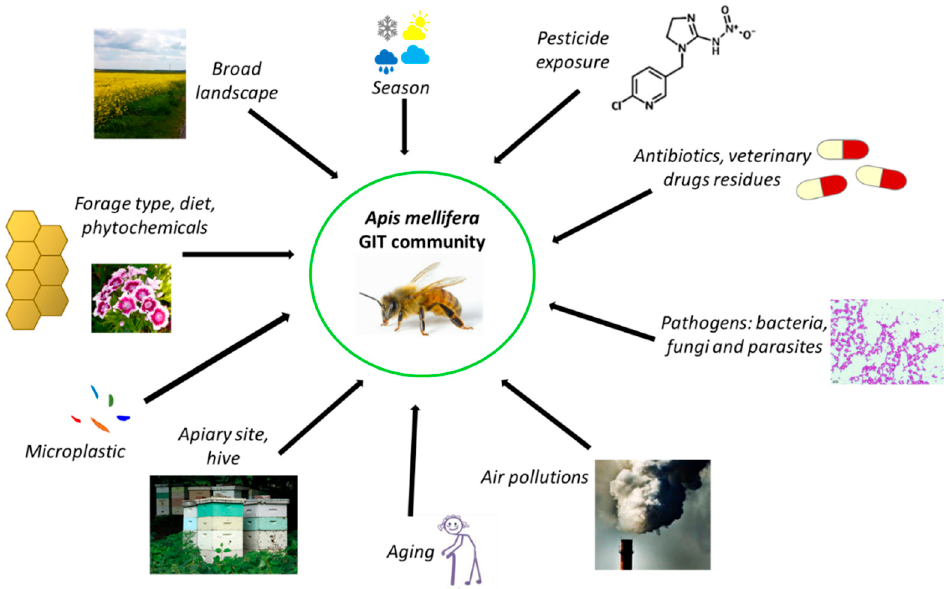
Figure 3. Possible factors affecting the microbiome of A. mellifera GIT (gastrointestinal tract) (references in the text).